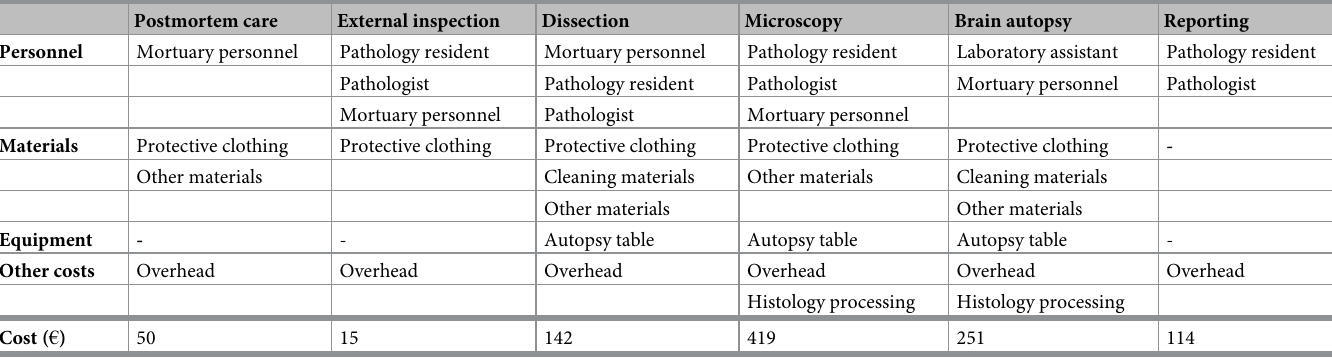
Table 6. Costs of conventional autopsy.